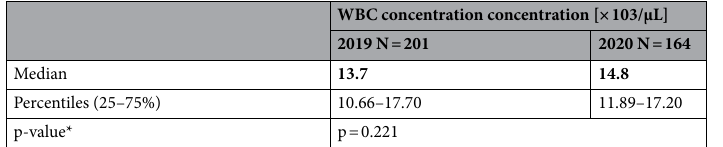
Table 1. WBC concentration in plasma of children treated because of an appendicitis in the years 2019 and 2020. *A p value < 0.05 is considered to show a significant difference between groups (according to the Mann– Whitney U test).